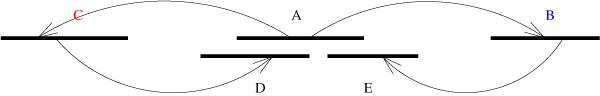
Narrowing gaps. Because of the standard deviation of insert-length, gap between successive contigs reduces.